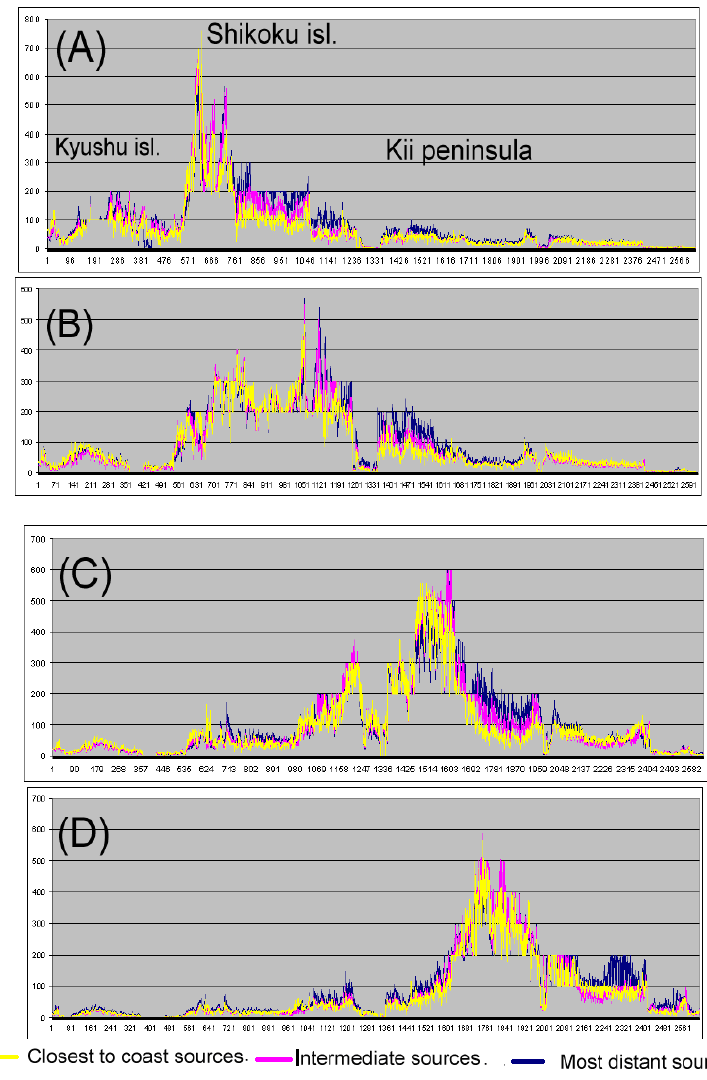
Figure 11. Distributions of tsunami wave maxima along the shore generated by the sources S0-a , b , c ( A ), S1-a , b , c ( B ), S2-a , b , c ( C ), and S3-a , b , c ( D ). Wave height maxima by the Si-a sources ( i = 0, 1, 2, 3) are drawn as yellow lines, those by Si-b sources as pink lines, and those by Si-c sources as blue lines. The horizontal axis shows the longitudinal coastline point position on the computational grid (see the lower part of Figure 3 for numbering).